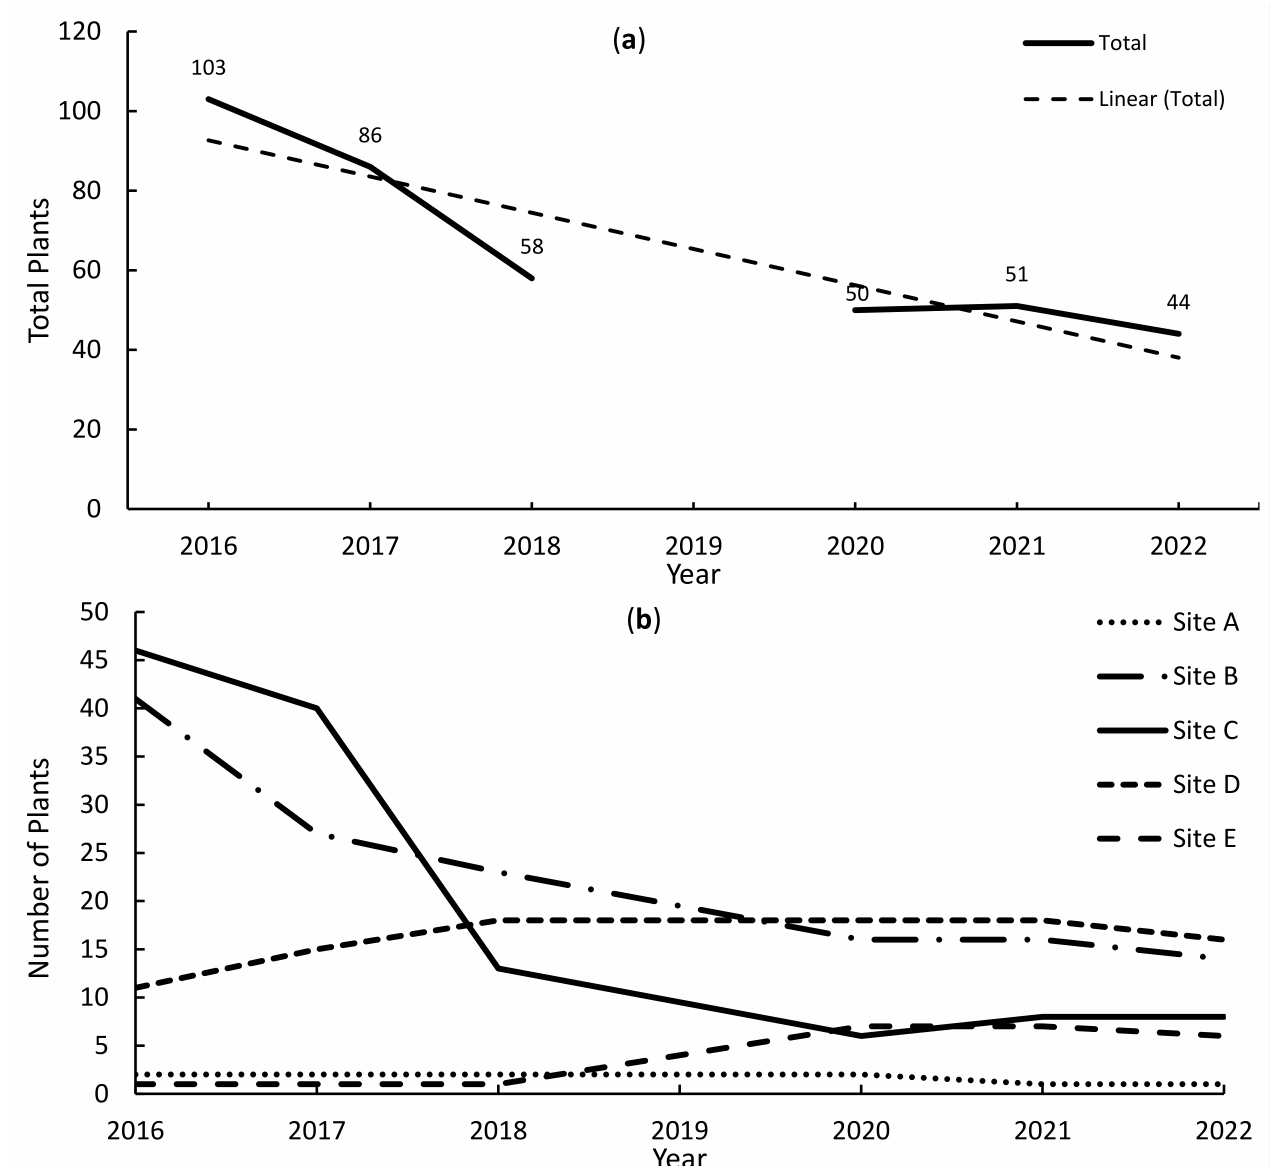
Figure 3. Total observed live populations of Campylocentrum pachyrrhizum on the FPNWR across all sites ( a ). Total observed live individuals for each of the sites that were surveyed ( b ). When ribbon orchid numbers were pooled for all five populations per year based on the four age classes (Figure 4), the majority of the individuals were either in Class 1 (small, 0–6.33 cm) or Class 4 (mature, >19.6+ cm), and the fewest were in Class 3 (12.8–19.6 cm) (Figure 2). All ribbon orchids that were observed to have dehiscent fruits were in Class 4, meaning the number of individuals that set seed during any given year was fewer than